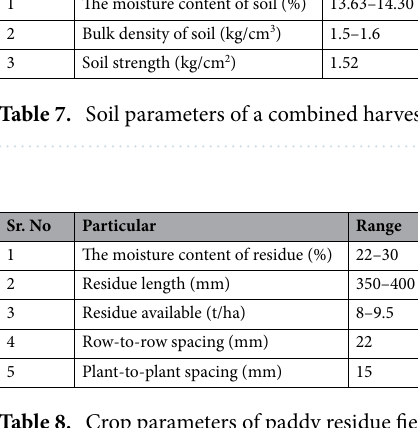
Table 8. Crop parameters of paddy residue